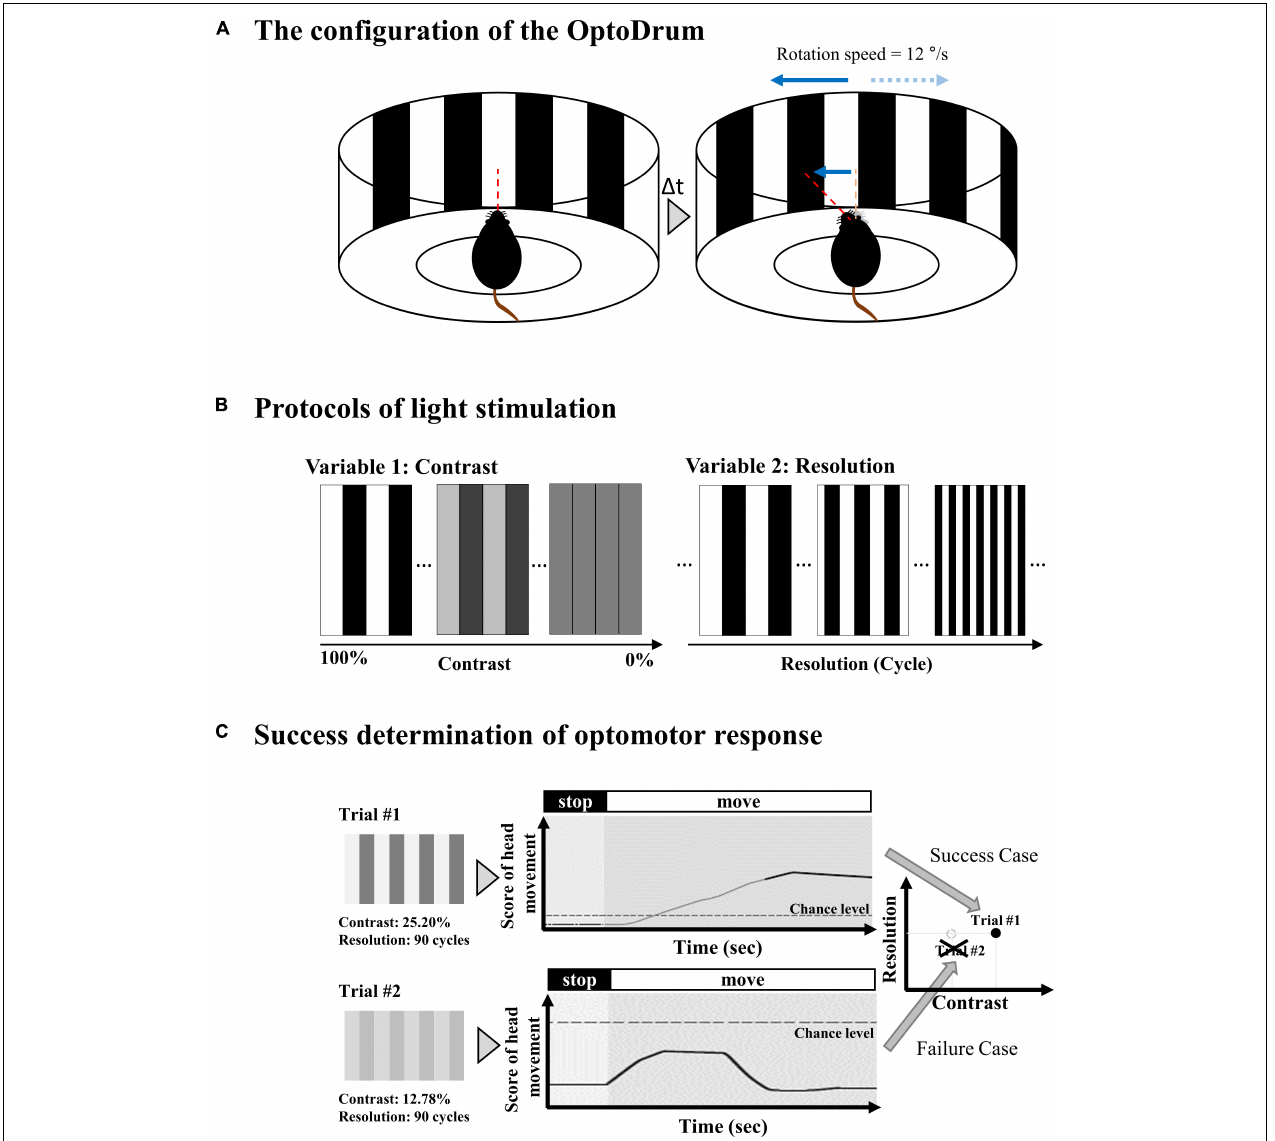
FIGURE 2 | Experimental setup for optomotor response. (A) The mouse is located in a virtual rotating drum center with a black and white stripe. The drum rotates clockwise or counterclockwise with 12 ◦ /s of velocity. (B) The stripe pattern of the virtual rotating drum can be modulated in terms of relative contrast between black and white bar and spatial resolution. The contrast changes from 100% (black = #000000 (Hex code color of RGB) and white = #FFFFFF) to 0% (black = #808080 and white = #808080). The spatial resolution changes from 0 cyc/ ◦ (cycles per degree) to 0.7 cyc/ ◦ . (C) Among experimental trials, the successful trial of optomotor response is determined if the head movement score exceeds the chance level of the stimulus-independent head